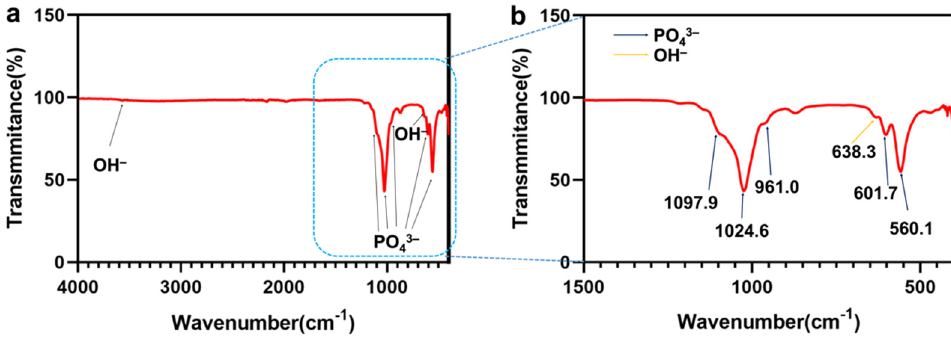
Figure 8. ( a ) FTIR spectrum of an HA-Ti disc. ( b ) Magnification of the spectrum marked by the blue rectangle in ( a ).